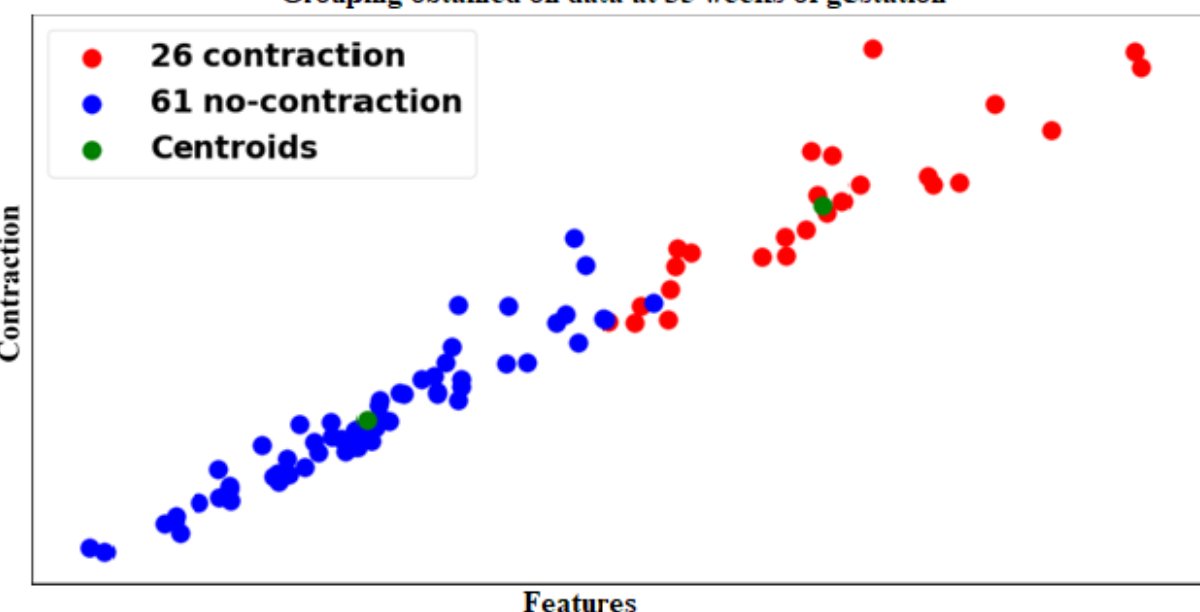
Figure 3. Application of K-means to the dataset.